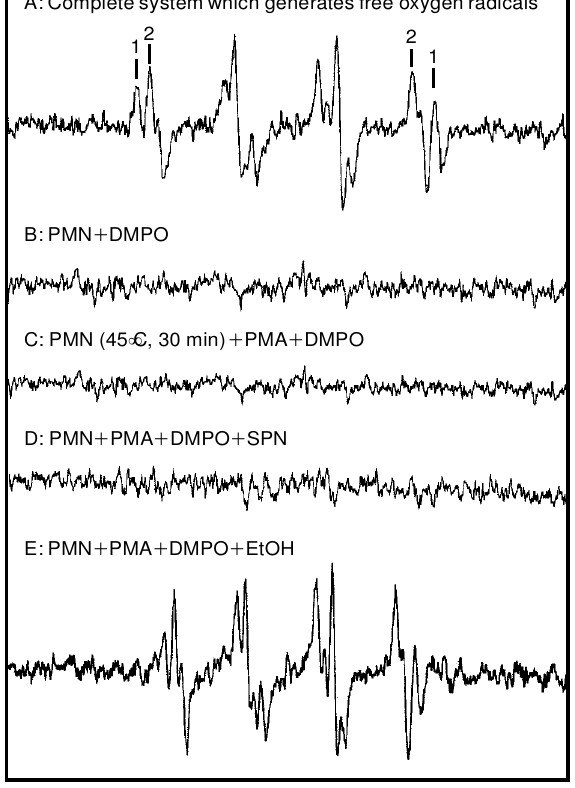
FIG. 1. ESR spectra from neutrophils (6 3 10 6 cells / ml) stimulated with PMA (5 3 10 - 7 M). For ESR conditions, see